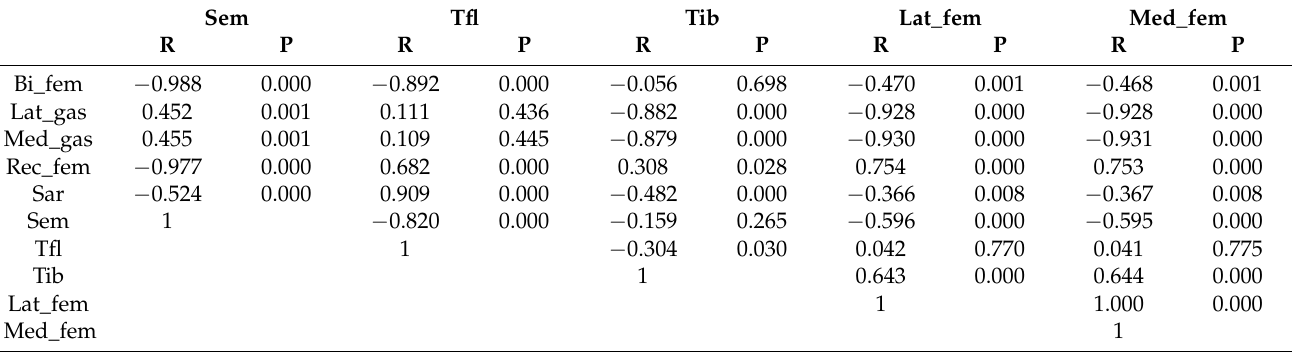
Table 2. Correlation between lower limb